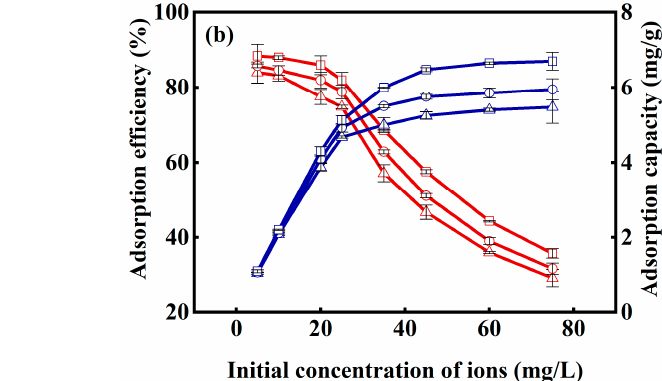
Figure 10. Cd adsorption isotherm model fitting: ( a ) Langmuir model; ( b ) Freundlich model . Table 4. Pb ion adsorption isotherm model fitting parameters . Temp./°C